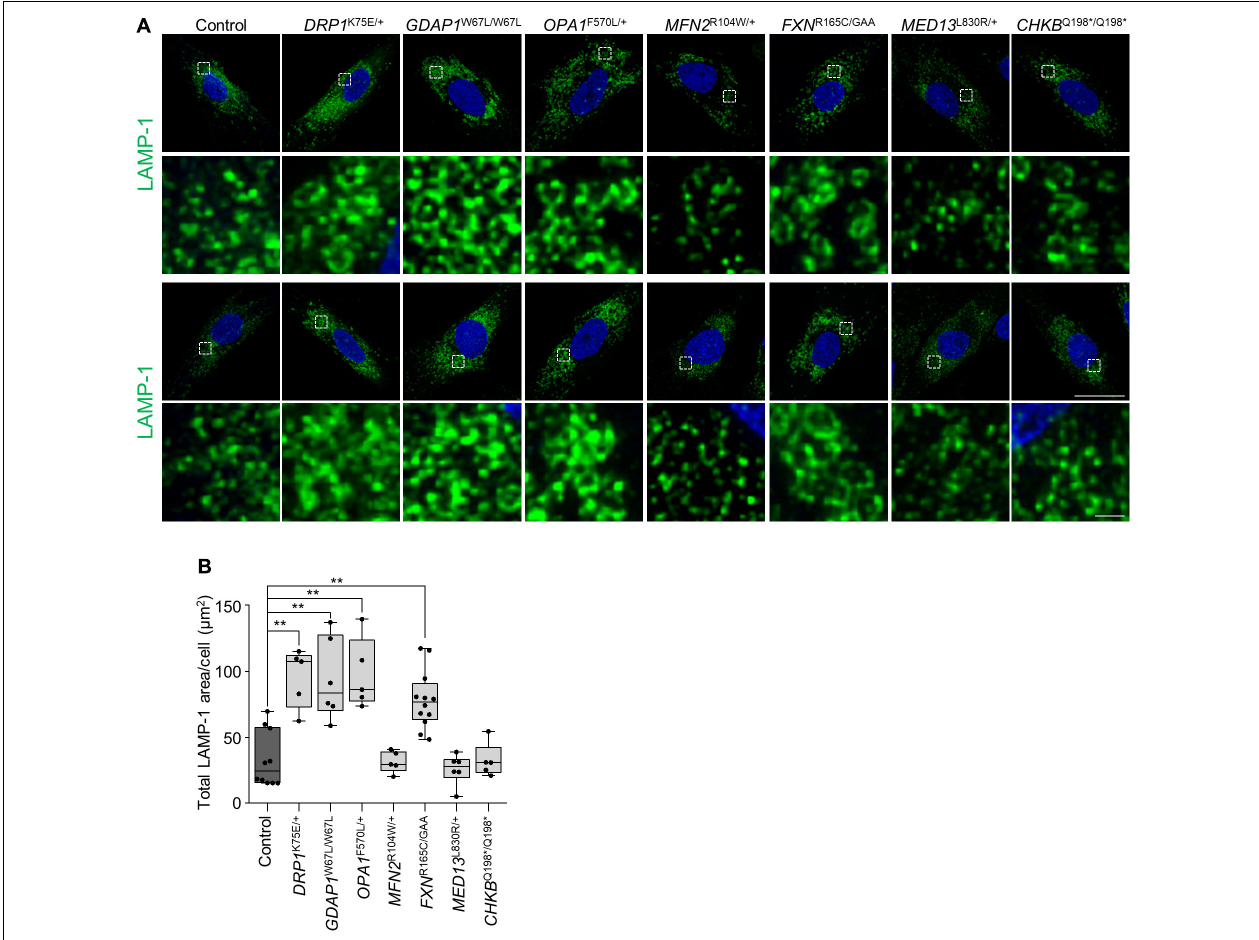
FIGURE 5 | Abnormal lysosomal morphology in patients’ fibroblasts. (A) Two representative images of LAMP-1 lysosome marker staining in control and patients’ fibroblast. A magnification is shown in the panel below. Scale bars: 25 and 1 µ m (detail). (B) Quantification of LAMP-1 total area per cell ( µ m 2 ). The box plot lines correspond from the bottom of the box to the top: 25th percentile, median percentile, 75th percentile. The whiskers extend to the minimum and maximum values. Three independent experiments with at least five slides were analyzed. Kruskal–Wallis followed by Dunn’s multiple comparisons test. ** P <